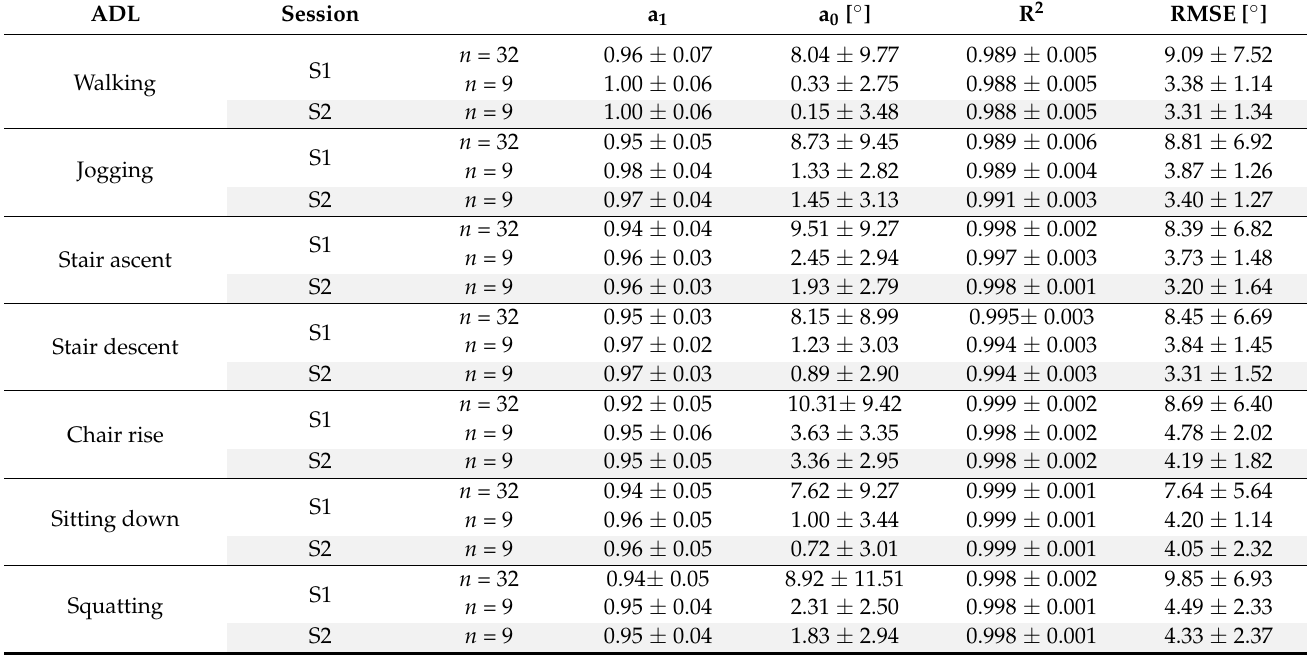
Table 1. Summary of the Linear Fit Method (LFM) outputs and root mean square error (RMSE) values (mean ± SD) for session 1 (S1) and session 2 (S2); ADL = activity of daily living.